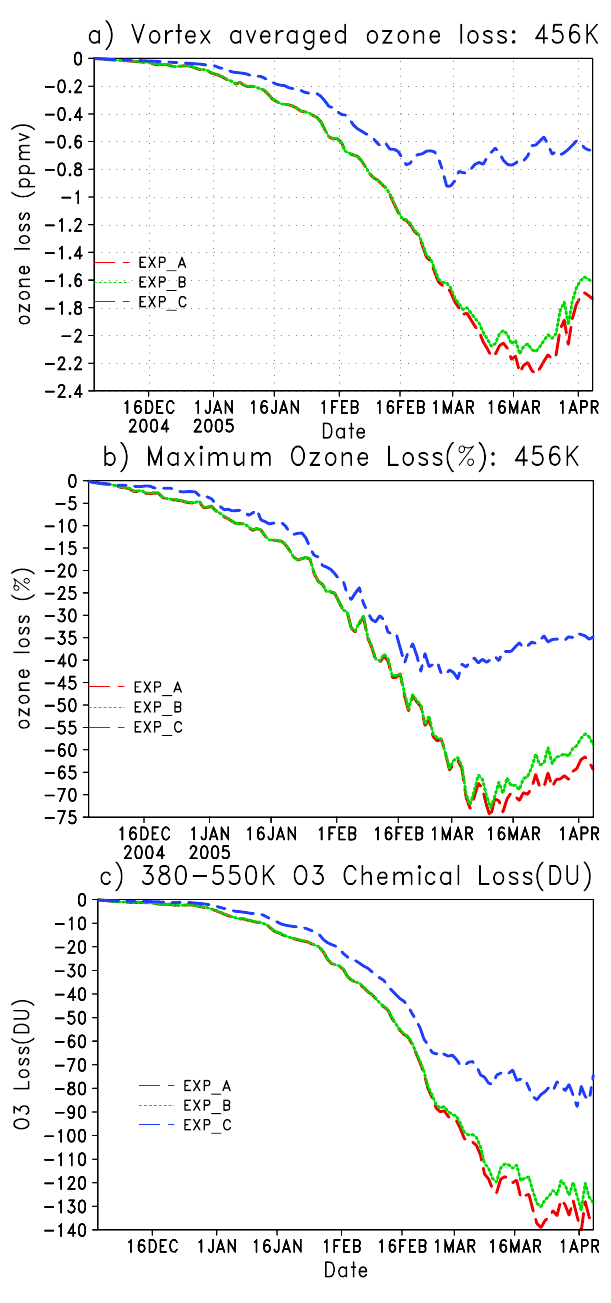
Fig. 7. Time series of (a) vortex-averaged ozone loss, (b) maximum local ozone loss at 456K ( ∼ 17km) and (c) partial column ozone loss between 380–550K ( ∼ 13–23km) from simulations EXP A and EXP B and EXP C for Arctic winter 2004/2005.